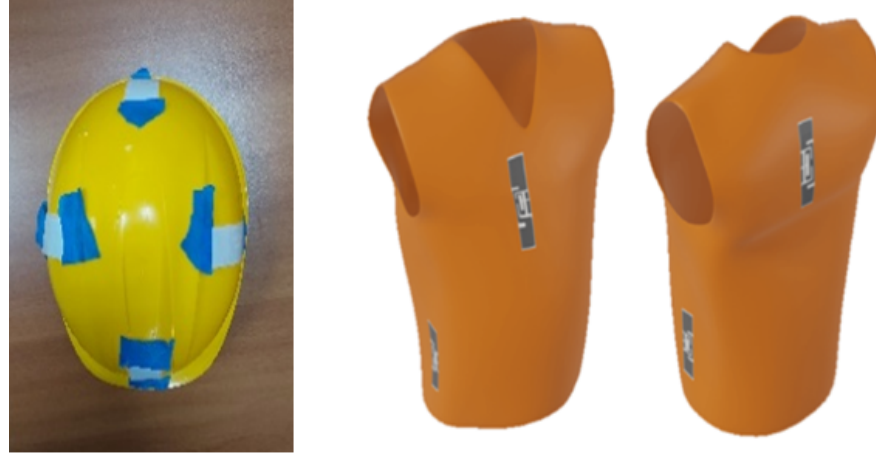
Figure 4. UHF-RFID tags vertically installed on a helmet and numerical model of tags installed on a